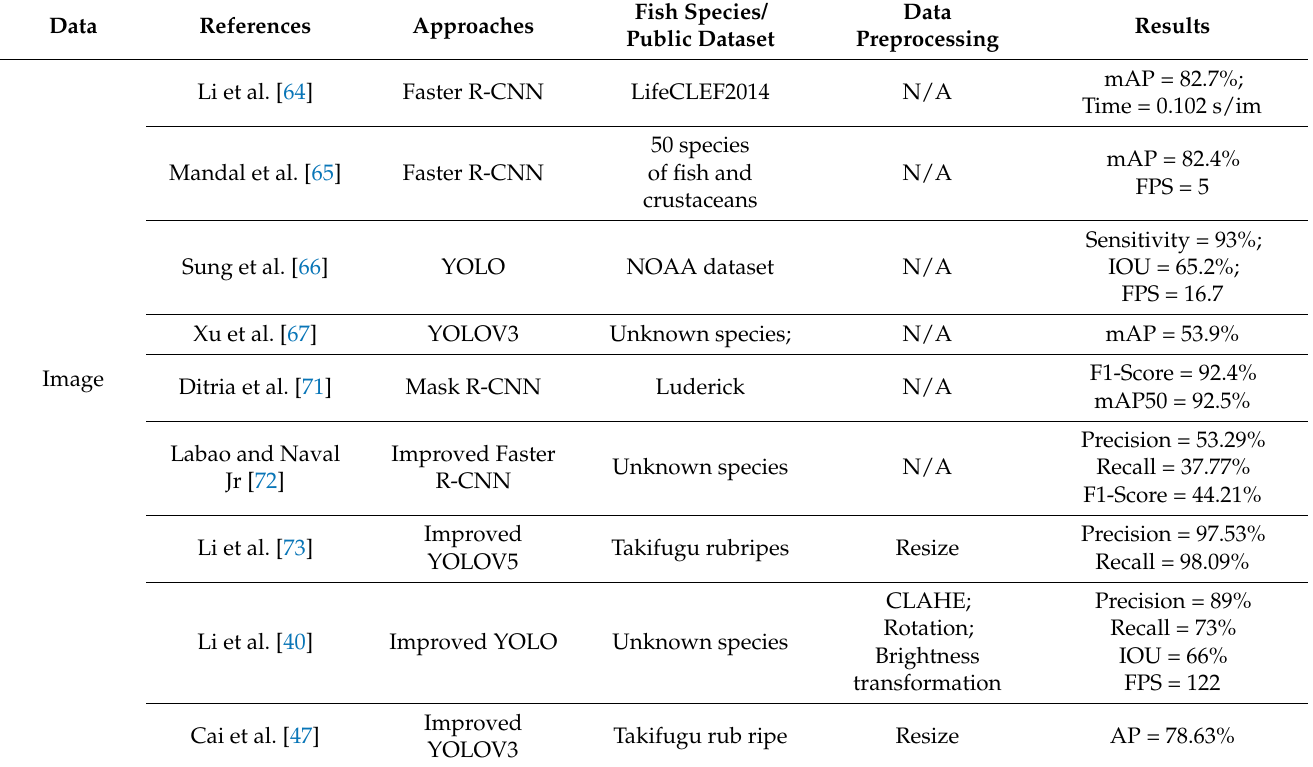
Table 3. Summary of DL-based object detection techniques applied in fish